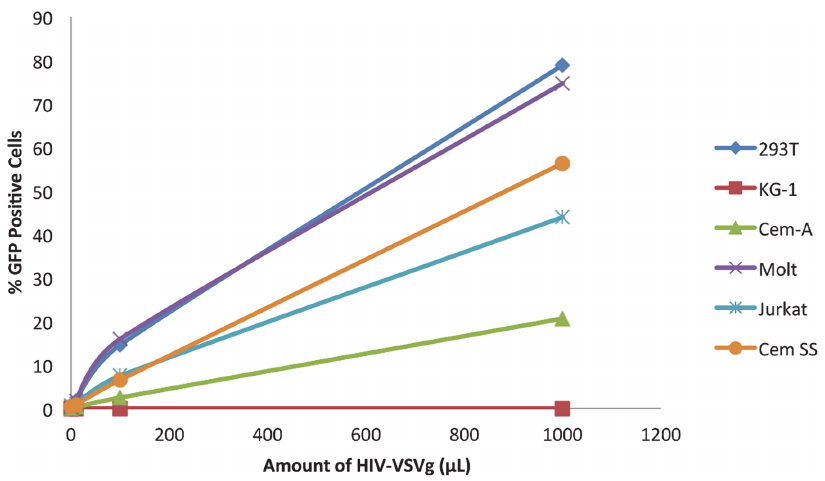
Fig 1. Infectivity of different human cell lines with HIV-VSVG. Several human cell lines were transduced with different amounts (3 log range) of HIV-VSVG that was produced in 293T cells. Percent of EGFP positive cells were determined using fluorescence cytometry 3 days post infection. The Fig. is representative of three independent experiments.